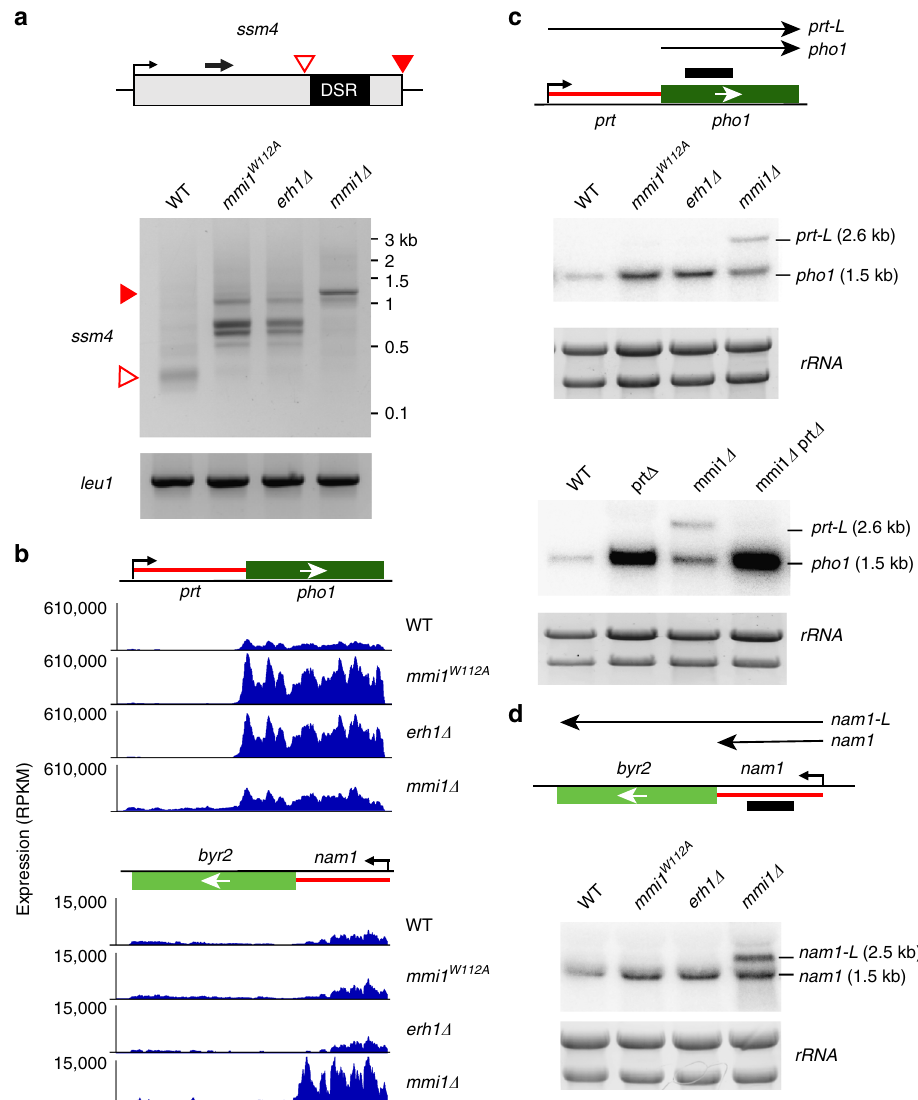
Fig. 8 Mmi1 W112A uncouples EMC-dependent and -independent Mmi1 functions. a 3 ′ RACE of ssm4 and leu1 (control) loci. Red triangles indicate termination sites as determined by sequencing of 3 ′ RACE products. The black arrow indicates the gene-speci fi c forward primer used, which can be found in Supplementary Table 4. b RNA-seq expression pro fi les of prt - pho1 loci and nam1 - byr2 in WT, mmi1 W112A , erh1 Δ , and mmi1 Δ . Shown is normalized RPKM expression. c Northern blot analysis at the prt - pho1 locus in indicated strains using a probe targeting pho1 mRNA (top and bottom panels). d Northern blot analysis at the nam1 - byr2 locus in indicated strains using a probe targeting nam1 ncRNA. Source data are provided as a Source Data fi